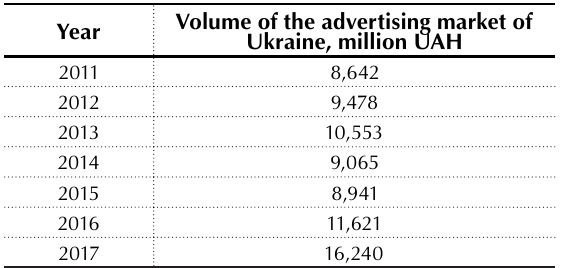
Table 2. The dynamics of the advertising market of Ukraine during the period 2011−2015